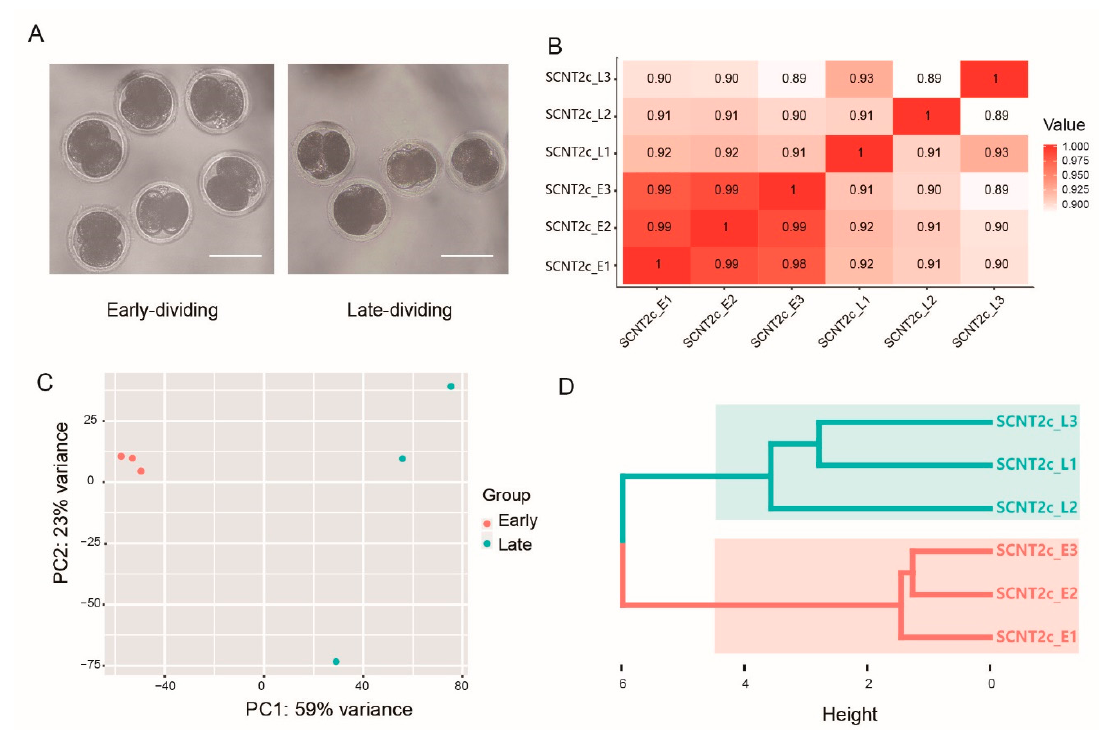
Figure 1. Morphology and global mRNA expression patterns of early-dividing and late-dividing SCNT 2-cell embryos. ( A ) The morphology of early-dividing (24 h postactivation) and late-dividing (36 h postactivation) SCNT embryos. The white bar represents 100 µm. ( B ) Heatmap of the Pearson correlation coefficient between each single embryo. ( C ) Principal component analysis of single embryos. ( D ) Unsupervised hierarchical clustering of single embryos.